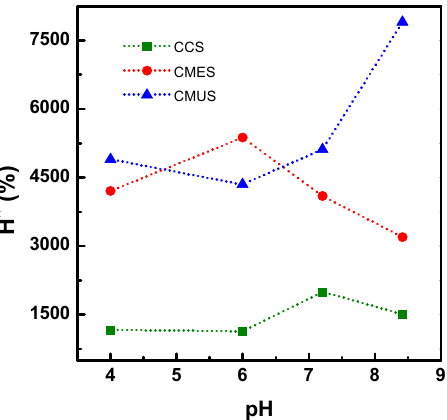
Figure 6. Swelling at the equilibrium of grafted copolymers as a function of pH.